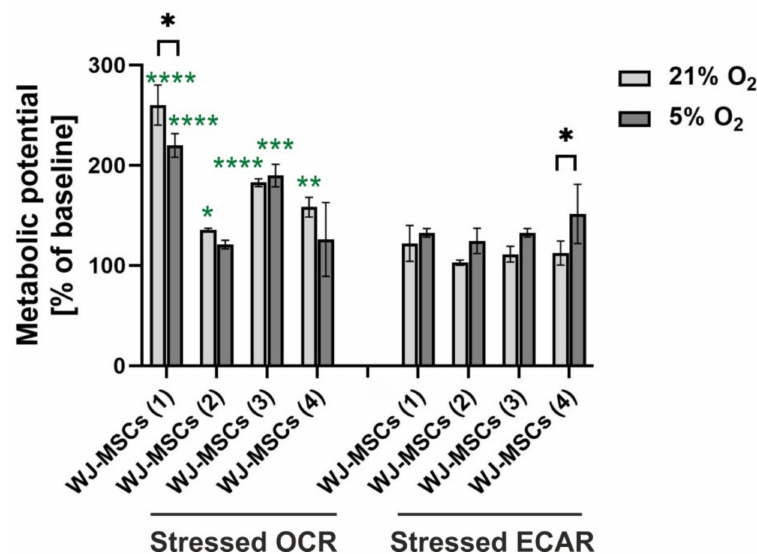
Figure 6. Metabolic potential of the hWJ-MSCs cultured under 21% O 2 and 5% O 2 (passage 2). The results are expressed as the mean ± SD for the individual donors ( n = 4). The asterisks denote significant differences (* p < 0.05, ** p < 0.001, *** p < 0.0001, **** p < 0.00001) between 21% and 5% oxygen concentrations (black asterisks) as well as between stressed oxygen consumption rate (OCR) and extracellular acidification rate (ECAR) (green asterisks).